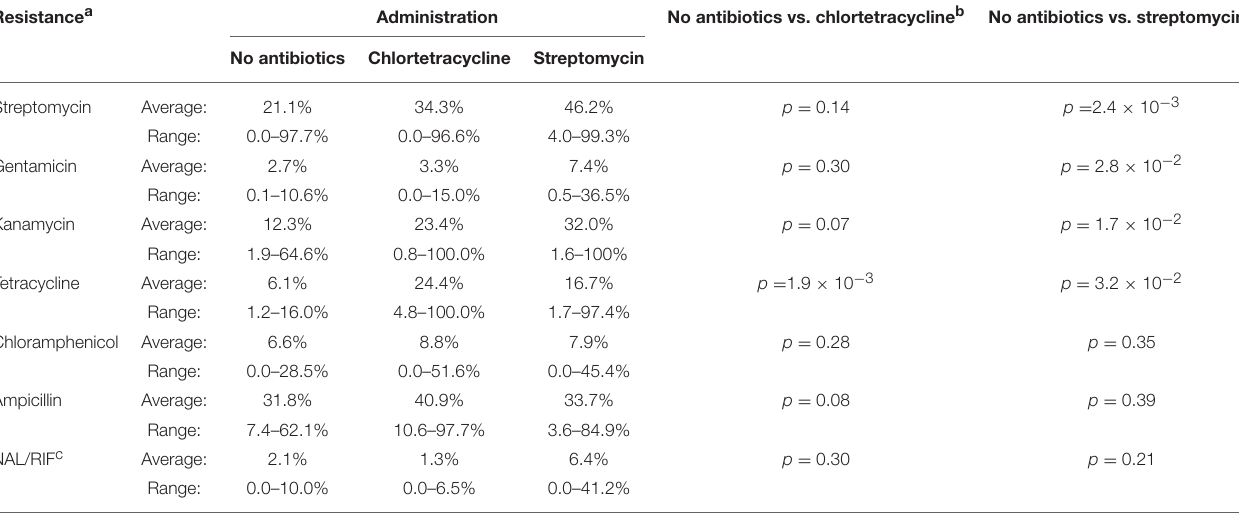
TABLE 10 | Antimicrobial resistance in Gram-negative bacteria isolated from chickens administered antimicrobials and chicken resistome. Resistance a Administration No antibiotics Chlortetracycline Streptomycin